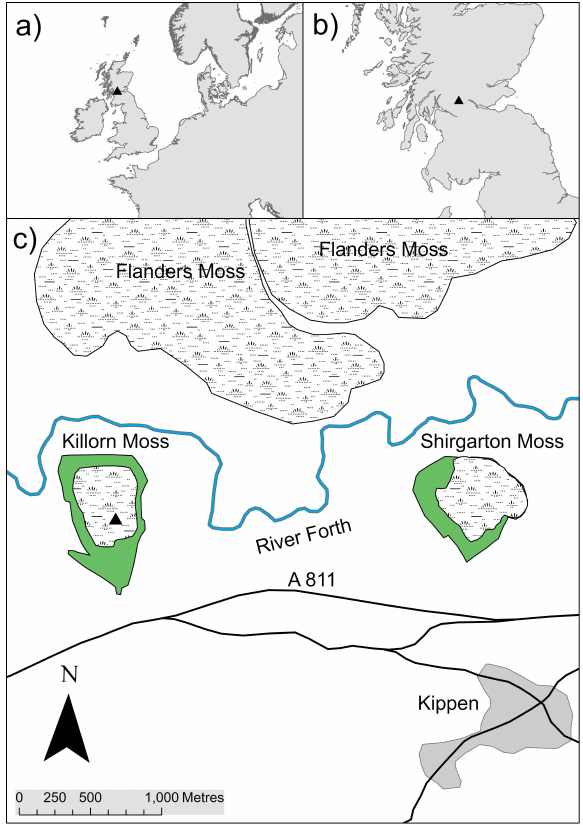
Figure 1. The location of Killorn Moss a) internationally, b) nationally and c) in relation to Shirgarton Moss. The green shading surrounding Killorn Moss and adjacent to Shirgarton Moss denotes tree